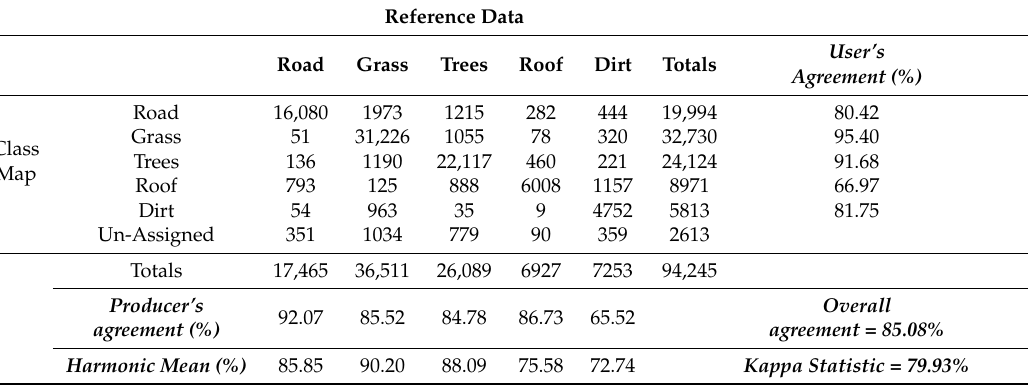
Table 7. Agreement matrix between Full+QT and reference map.